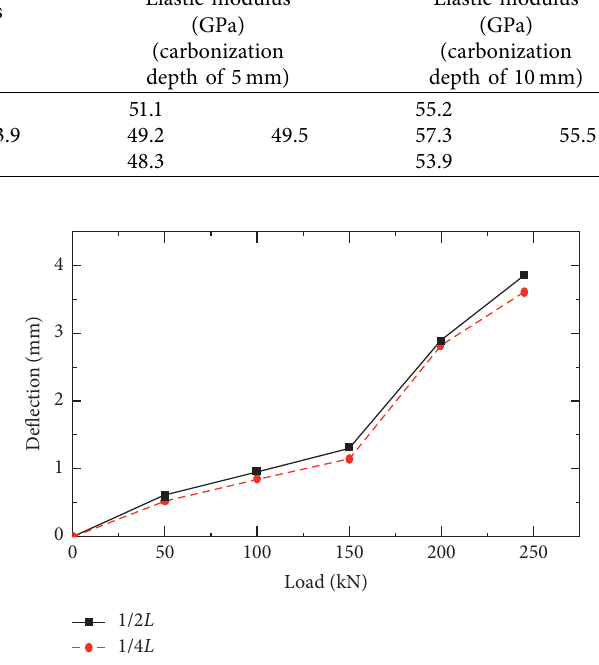
Figure 11: Load-deformation curves of static load